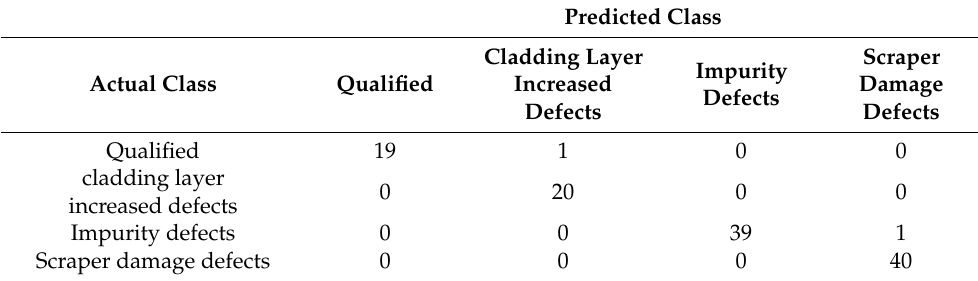
Table 1. The confusion matrix of the MLP classification results.